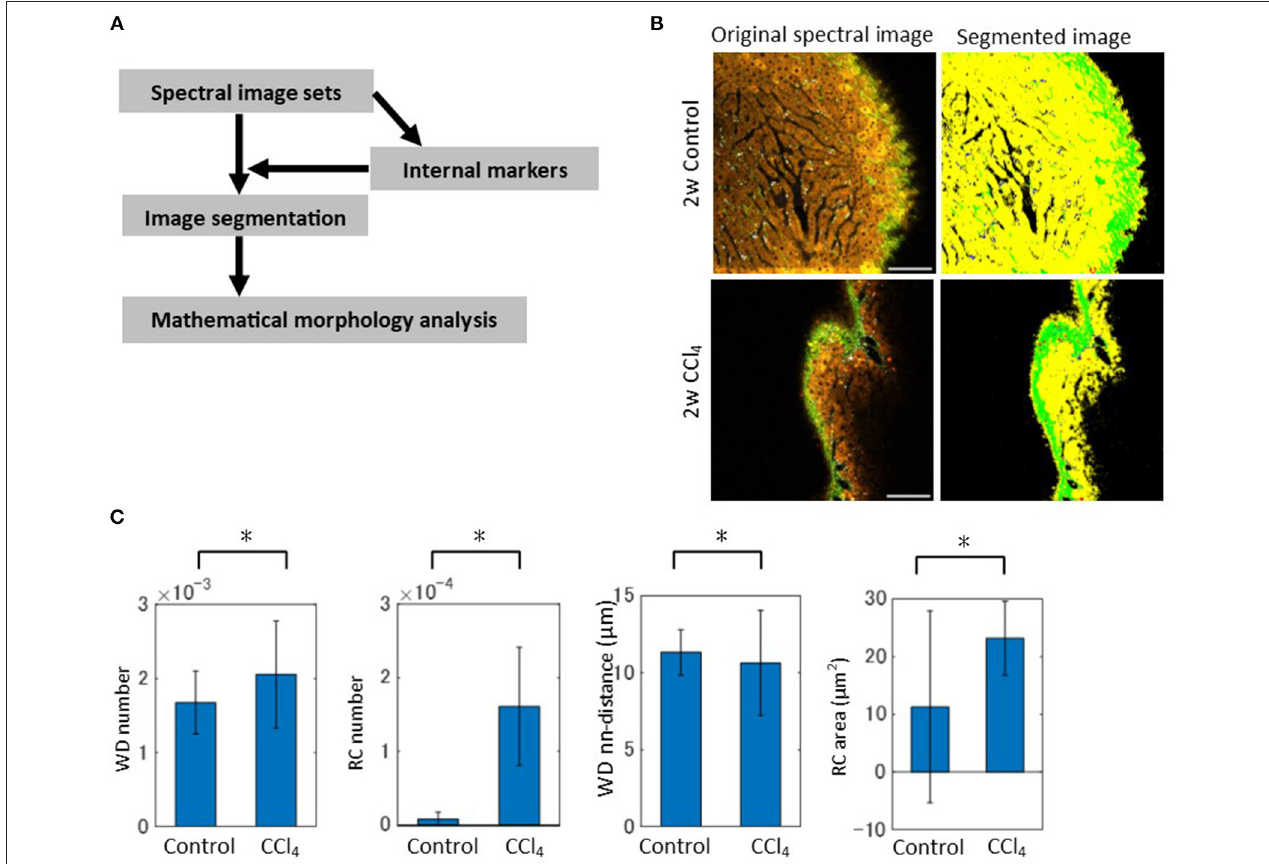
FIGURE 4 | Image segmentation and mathematical morphology analyses of spectral image data. (A) Schematic of the image processing workflow. The segmentation of spectral images was performed by assigning each pixel to the nearest centroid of the markers. The mathematical morphology analysis was then performed on the segmented images. (B) Original and segmented images reflecting the regions of HP, SHG, WD, and RC are shown. Segmented images representing HP, SHG, WD, and RC are in yellow, green, white, and red, respectively. (C) Mathematical morphology analyses of the segmented images. The graphs shown are the ratios of the number of WD sites and RC sites to the total signal area, the averaged nearest neighbor distance between WD sites, and the averaged areas of RC to the total signal area. Asterisks indicated statistical significance with the Kolmogorov-Smirnov test with a p <